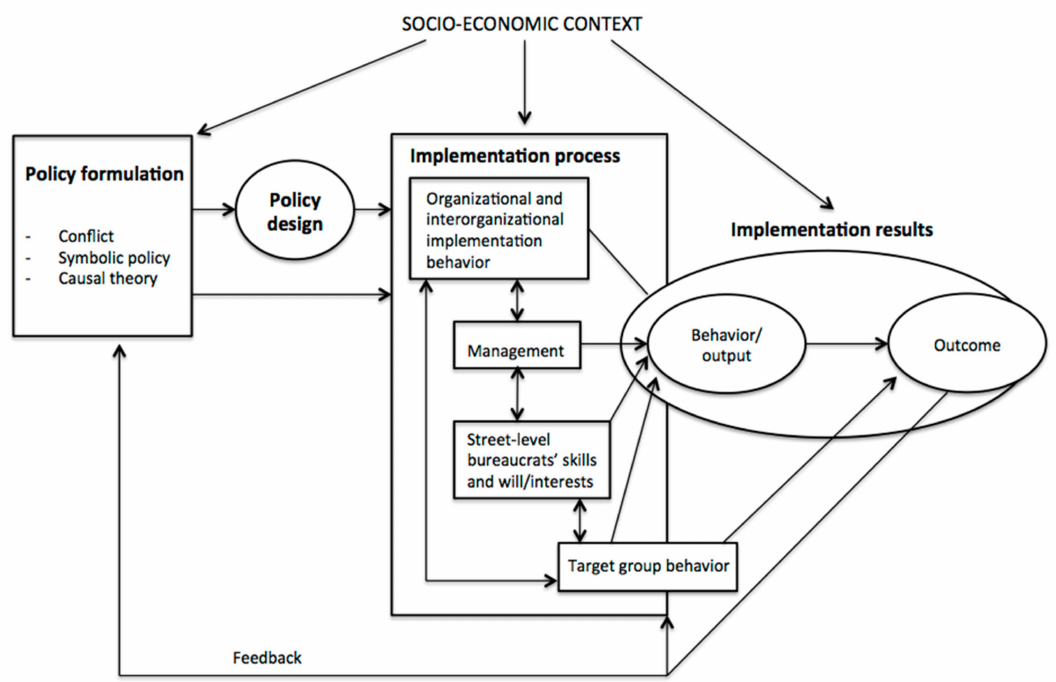
Figure 1. Integrated Implementation Model. Source: Winter, Søren. 1990. “Integrating Implementation Research.” In (Palumbo and Calista 1990; Winter